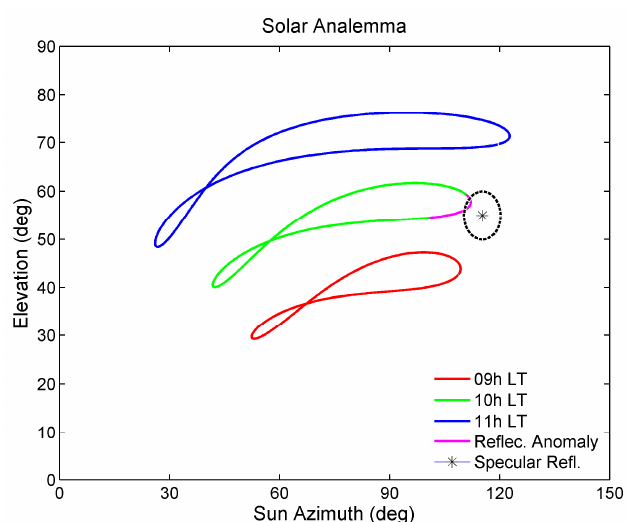
Figure A3. Analemma for 9 h (red), 10 h (green), and 11 h (blue) LT at Serra da Mesa reservoir (SIMA buoy coordinates) and corresponding specular reflection opposed to satellite viewing angles (black). Dash-dotted black line indicates a 5° margin from the specular position.